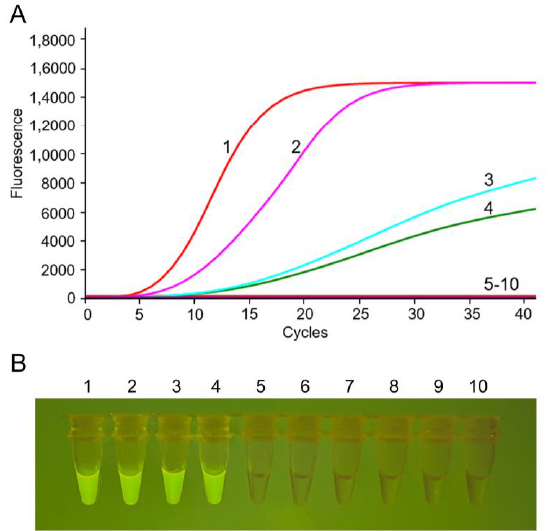
Figure 3. Specificity of the RF-RT-RAA assay for PRRSV-2. ( A ) Amplification results of RF-RT-RAA through real-time fluorescence read-out. ( B ) Amplicons of RF-RT-RAA observed with the naked eye under blue light. The image was captured by a mobile phone camera. Curves or tubes 1–4: RF-RT-RAA detection results of PRRSV-2 strains VR-2332 (RNA, 388 ng/ µ L), JS07 (RNA, 305 ng/ µ L), JXA1 (RNA, 206 ng/ µ L), and SH1705 (RNA, 178 ng/ µ L), respectively; curves or tubes 5–10: RF-RT-RAA detection results of PRV (DNA, 215 ng/ µ L), PEDV (RNA, 226 ng/ µ L), PCV2 (DNA, 264 ng/ µ L), TGEV (RNA, 314 ng/ µ L), PPV (DNA, 185 ng/ µ L), and negative control, respectively; PRV, porcine pseudorabies virus; PEDV, porcine epidemic diarrhea virus; PCV2, porcine circovirus type 2; TGEV, transmissible gastroenteritis virus; PPV, porcine parvovirus.